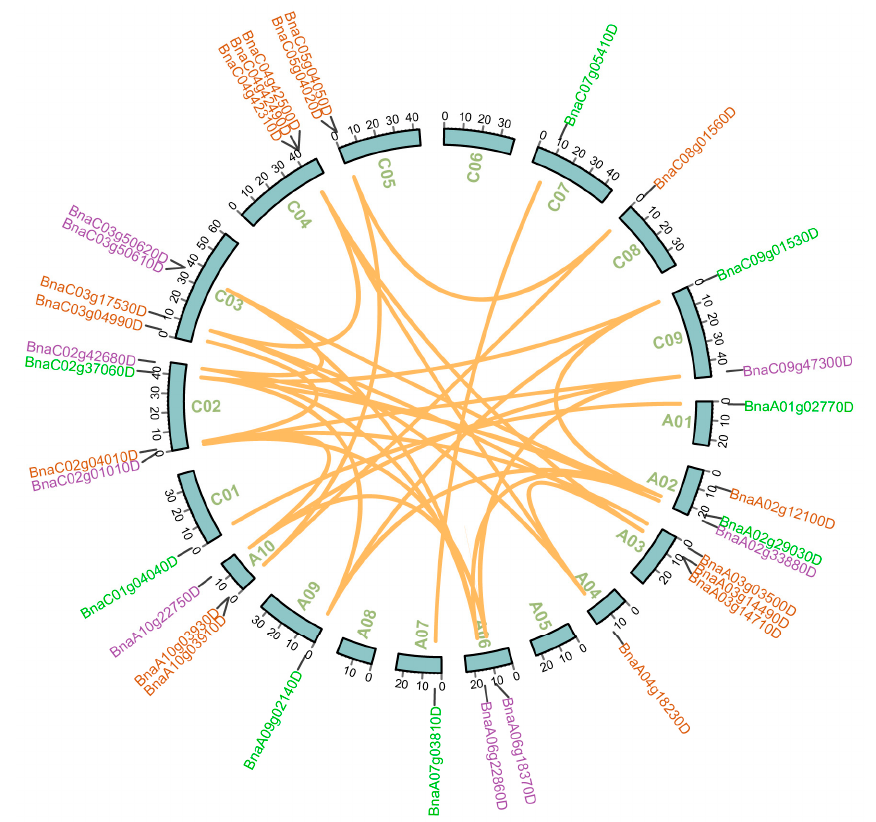
Figure 2. The chromosomal locations and duplicated genes analysis of ARI genes in B. napus . The locations of all the chromosomal BnARI genes are represented on different chromosomes, excluding the random fragment chromosomes. The different colors mean different BnARI subfamilies genes. Subfamily A, subfamily B and subfamily C are indicated by green, brown and purple color, respectively. The orange lines are used to highlight the duplicated BnARI gene pairs.